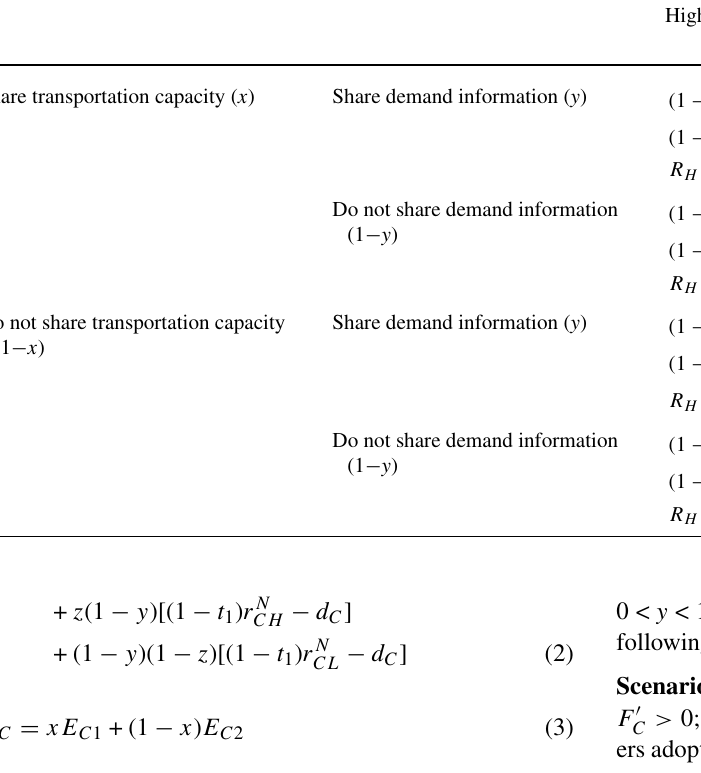
Table 2 Return matrix of the three freight transportation participants Freight